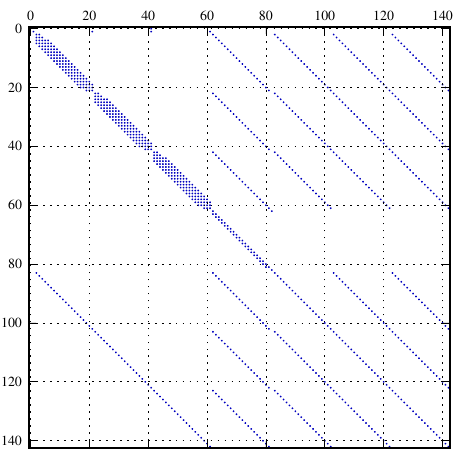
Figure 4. The sparsity pattern of the Jacobian of the spatially discretized, with n v = 20, and ODE transformed